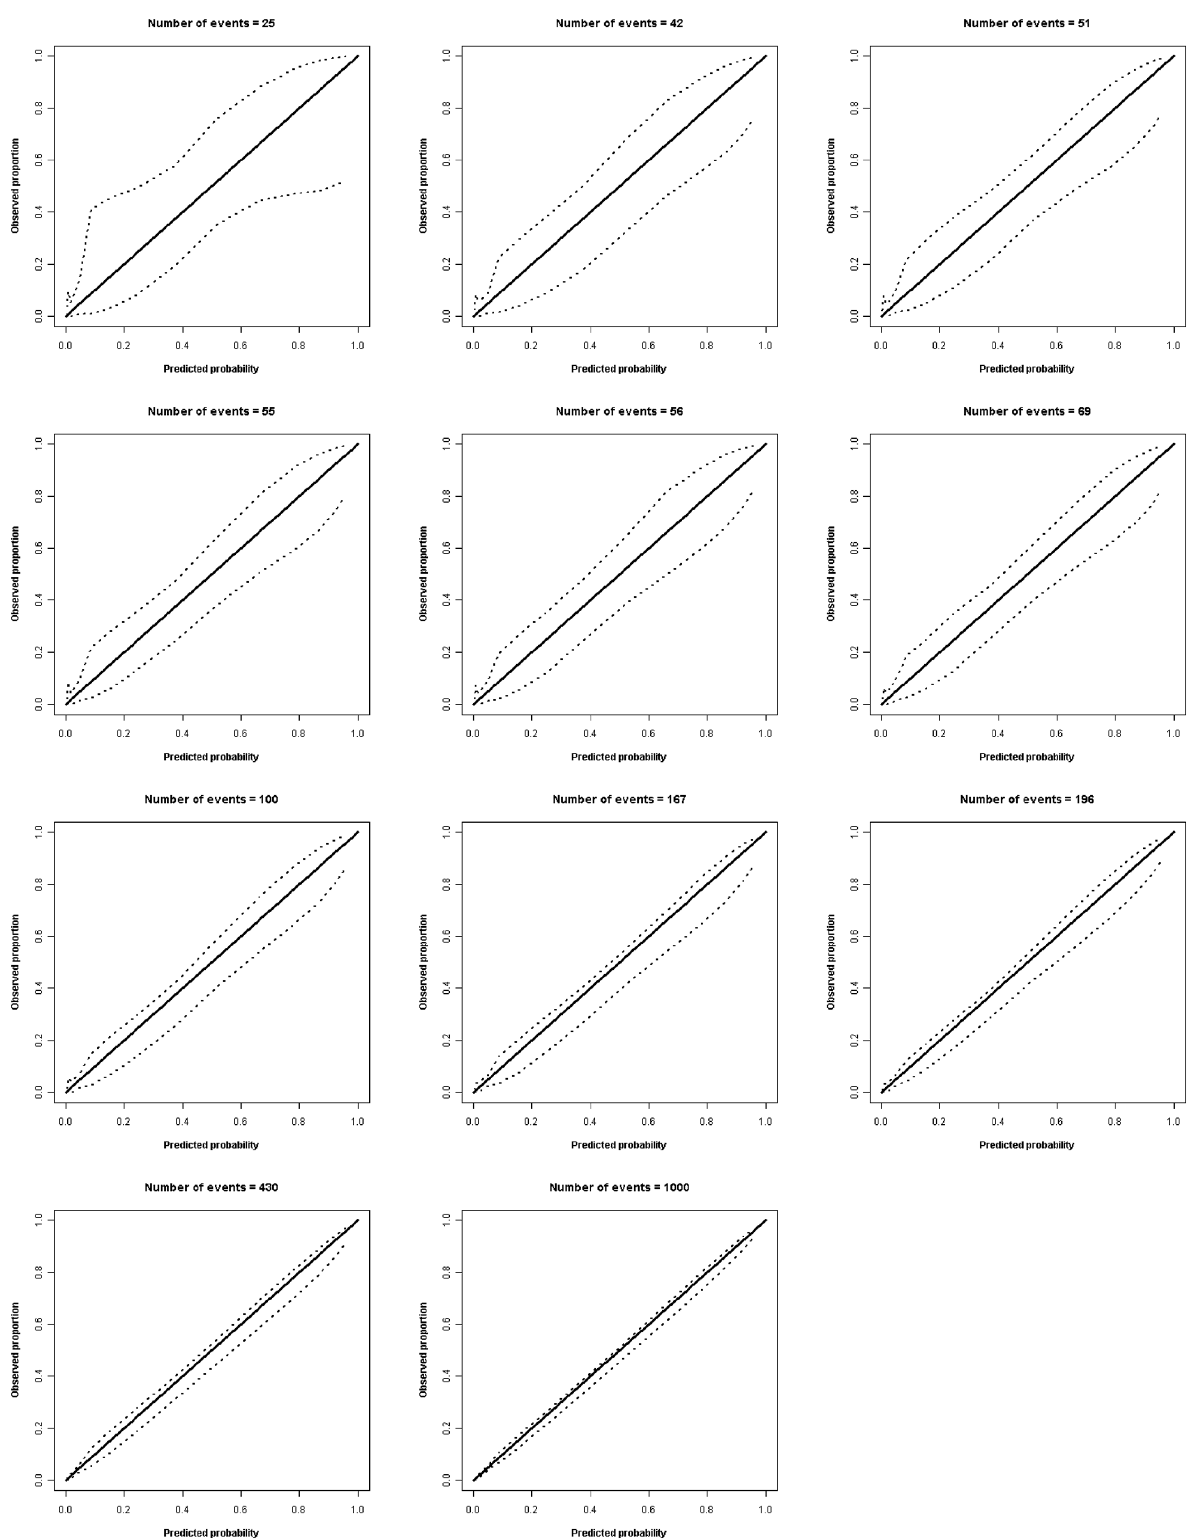
Fig 3. Smooth calibration plots (linear splines) for several sample sizes. The dashedlines denote the confidenceintervals. The central line denotesthe perfect prediction.